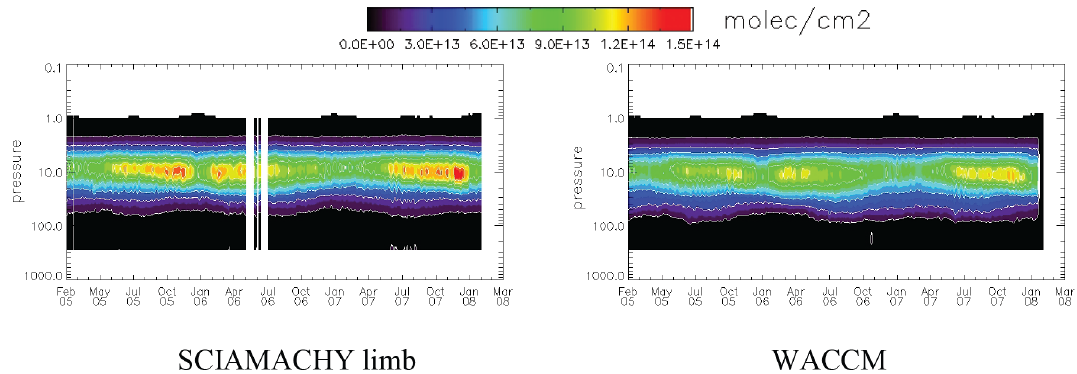
Figure 9b. Time trends in stratospheric NO 2 partial column profiles at Equator from SCIAMACHY (left plot) and WACCM (right plot).